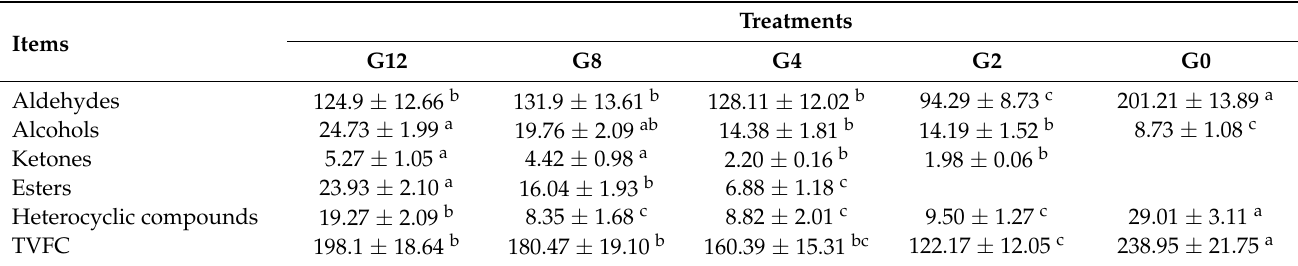
Table 9. Influence of restricted grazing time and indoor supplementary feeding systems on the total aldehydes, alcohols, ketones, esters, and heterocyclic compounds of LT muscle in Tan lamb